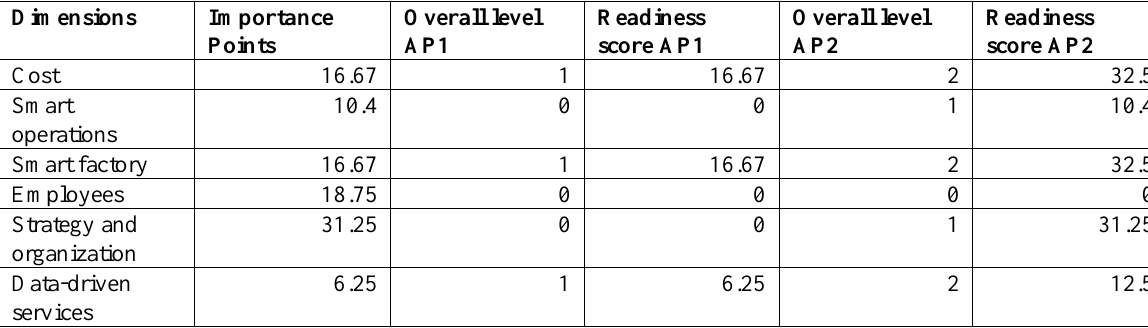
Table 5 . Scores for each